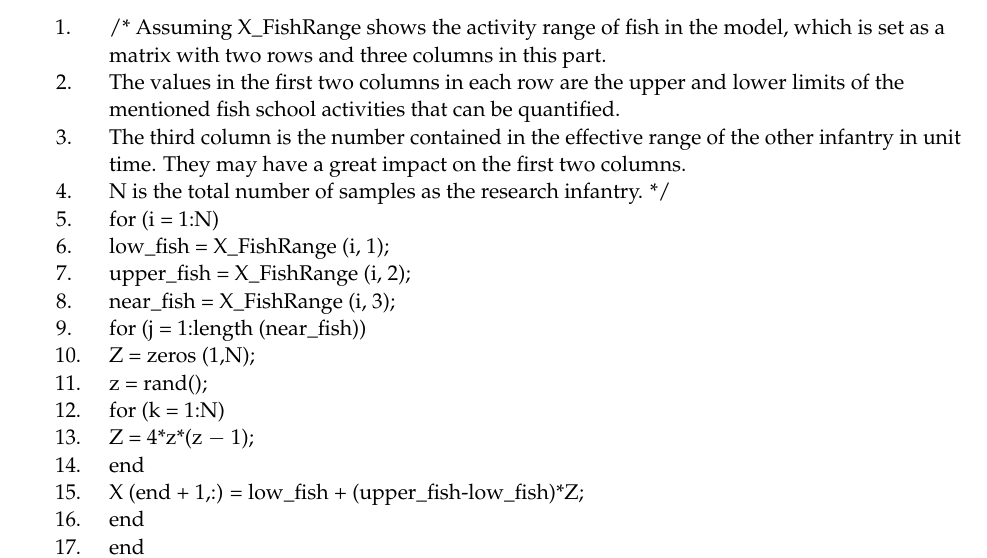
Algorithm 1 Adaptive initialization method based on Chaotic